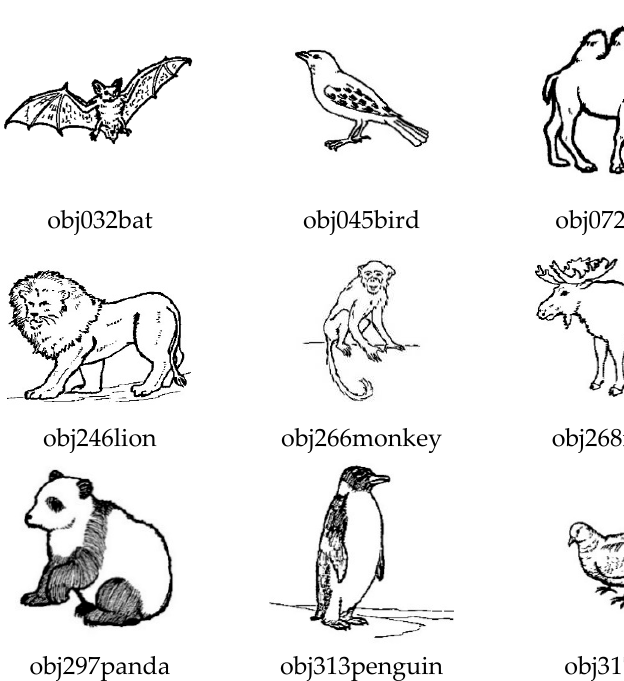
Figure A3. Animal pictures.